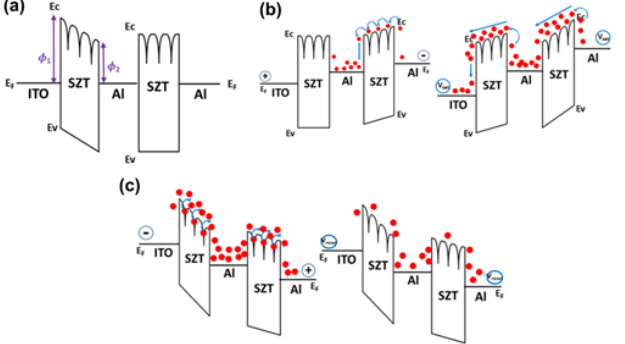
Figure 7. Possible resistive switching mechanism of Al/SZT/Al (18 nm)/SZT/ITO devices. ( a ) Ther- mal equilibrium, ( b ) negative bias, and ( c ) positive bias.